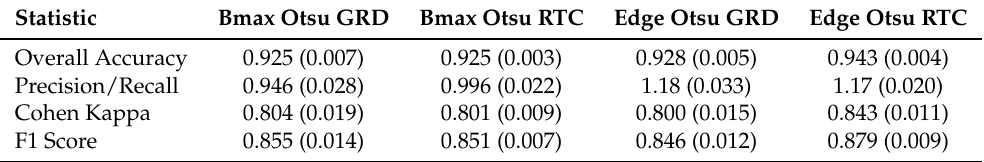
Table 2. Statistical evaluation of all input sample points for each algorithms (Bmax Otsu and Edge Otsu) and each dataset (GRD and RTC). Values are mean metric (stand deviation is in parentheses) of metrics across the different